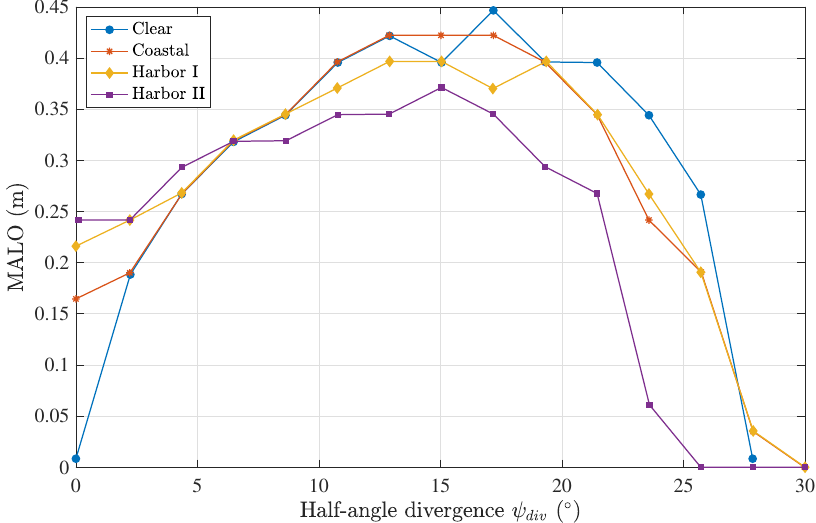
Figure 11. MALO calculation as a function of the divergence of the emitter for different water types, considering a seven-lens scheme and a Tx–Rx distance of